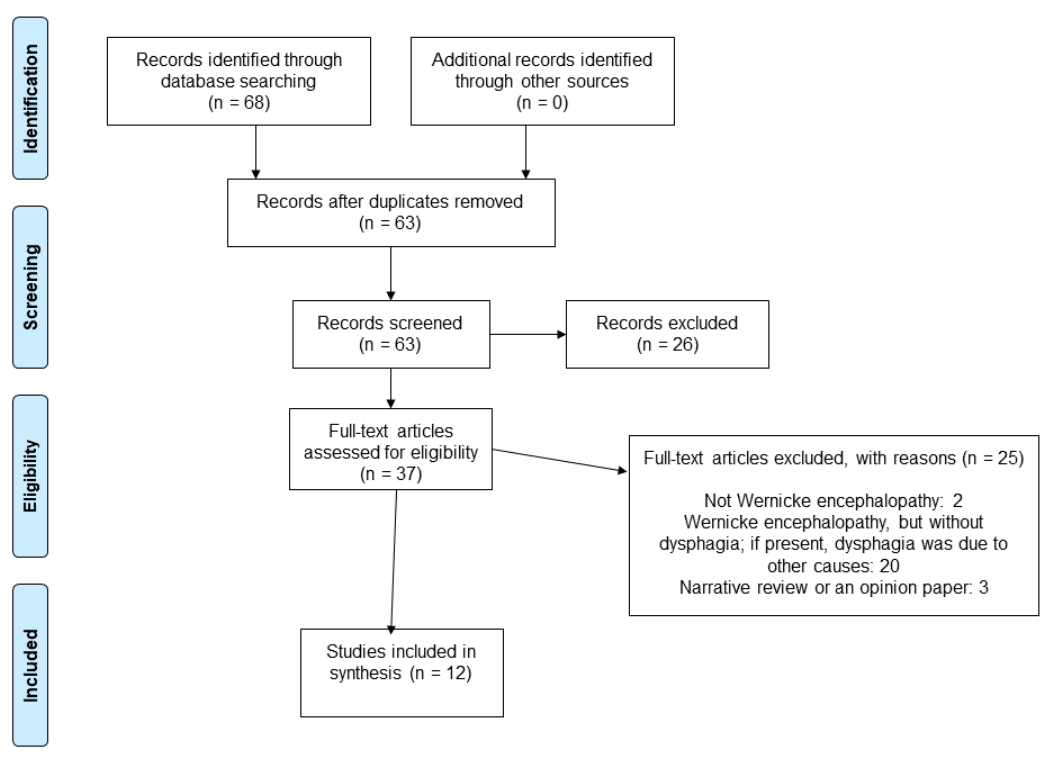
Figure 1. Flow chart showing the process for inclusion of studies . Twenty-five articles were excluded for the following reasons: patient did not have WE (n = 2); patient had WE but without dysphagia; if present, dysphagia was due to other causes (e.g., psychiatric illness, esophageal disease) (n = 20); article was a narrative review or opinion paper (n = 3).